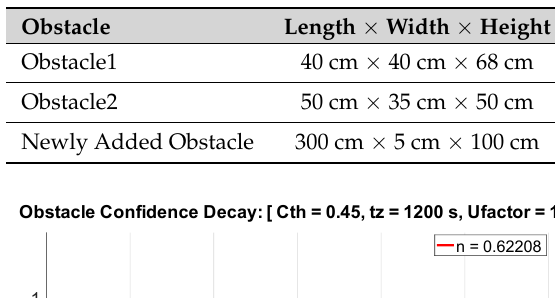
Figure 13. 2D gridmap updated by Turtlebot during navigation. Table 3. Obstacle Dimensions in the Experiment.